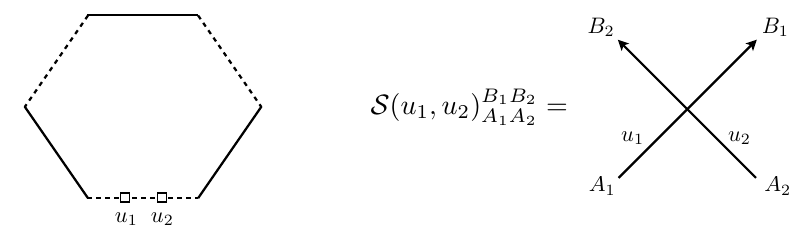
Figure 3 . Two-magnon hexagon form factor and its matrix part. A pair of magnons on a mirror edge is absorbed by the hexagon. The module of the amplitude is controlled by the abelian factor h ( u 1 ; u 2 ). The matrix part accounts for the contraction of the magnons’ left and right indices. Raising the right indices with the conjugation matrix, we can write it as the matrix element of the fundamental S matrix shown in the right S